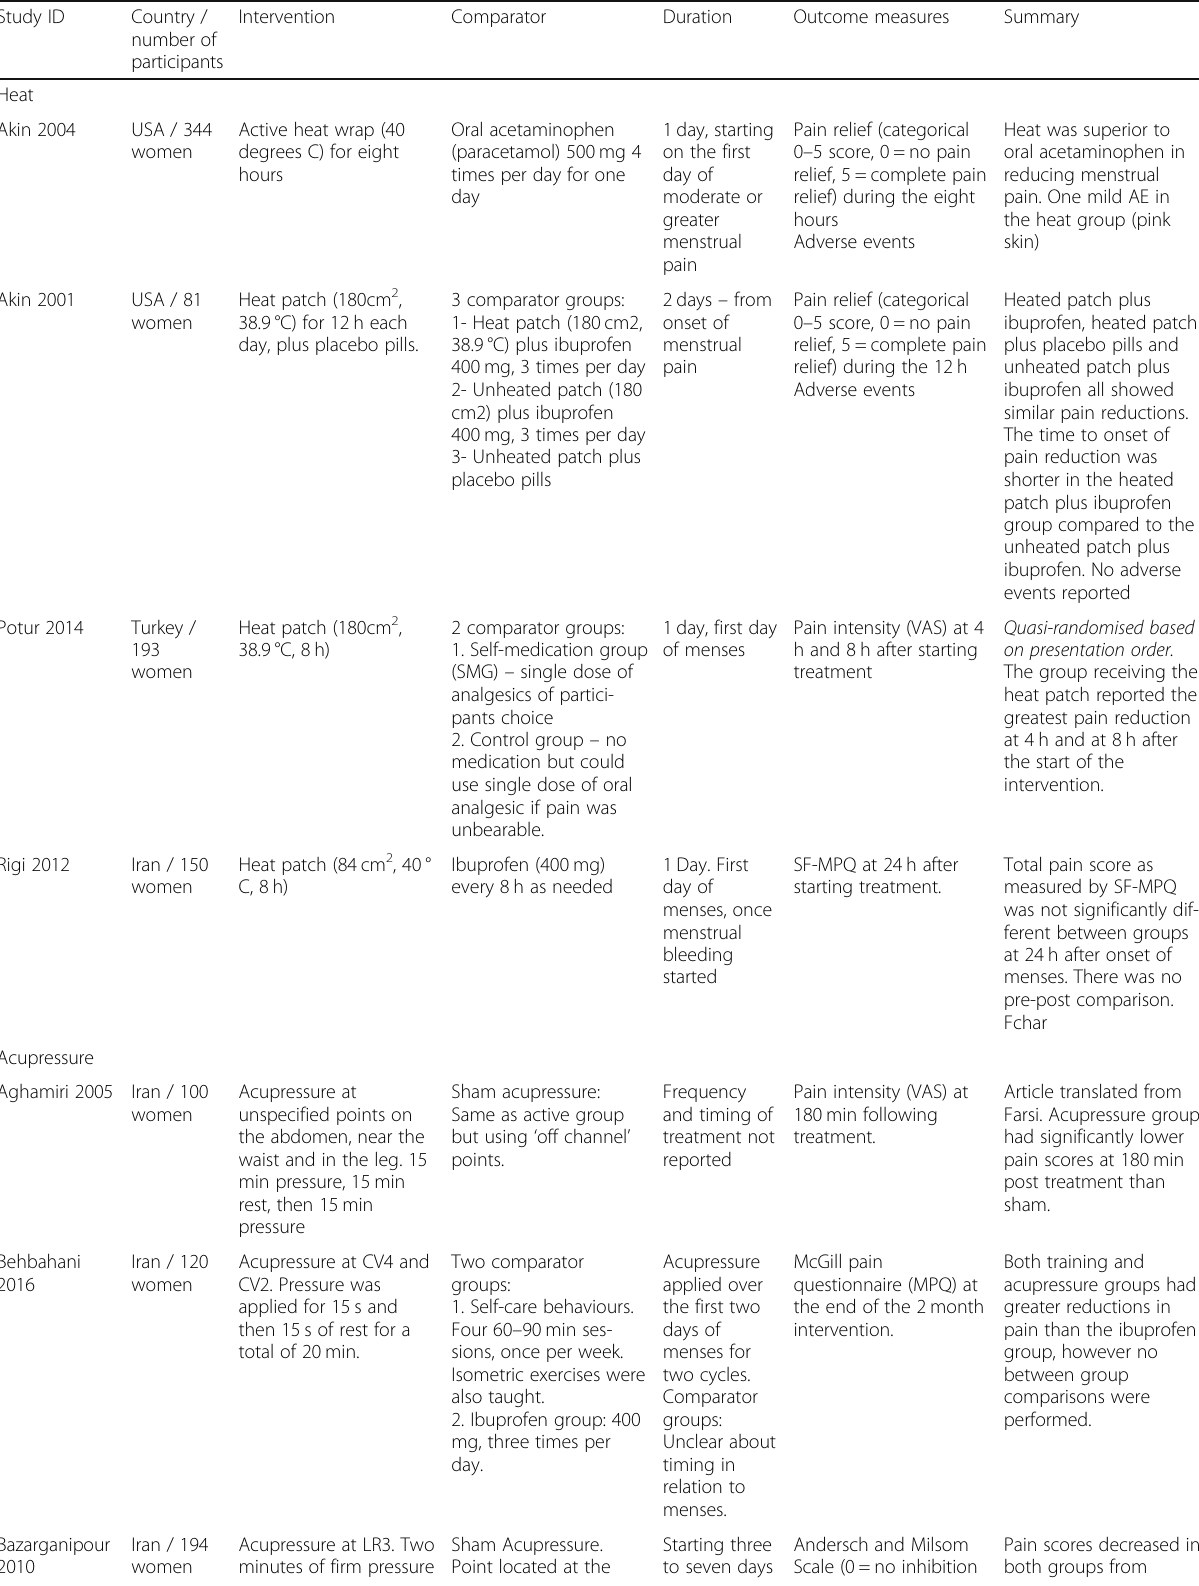
Table 1 Characteristics of included